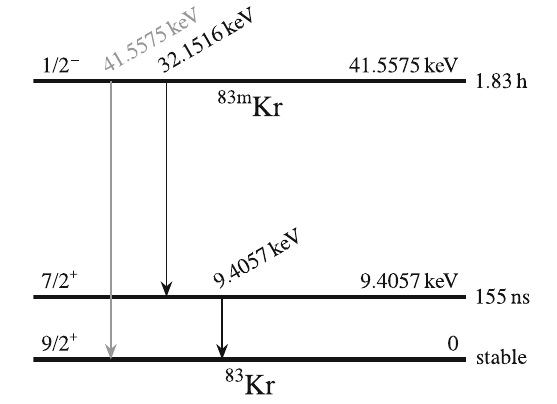
Fig. 1 Isomeric transitions of 83 Kr. The values were taken from [13] and the low-intensity cross-over transition was added. A signature of the conversion electrons from this transition has been observed in the detector spectrum during routine 83m Kr measurements at